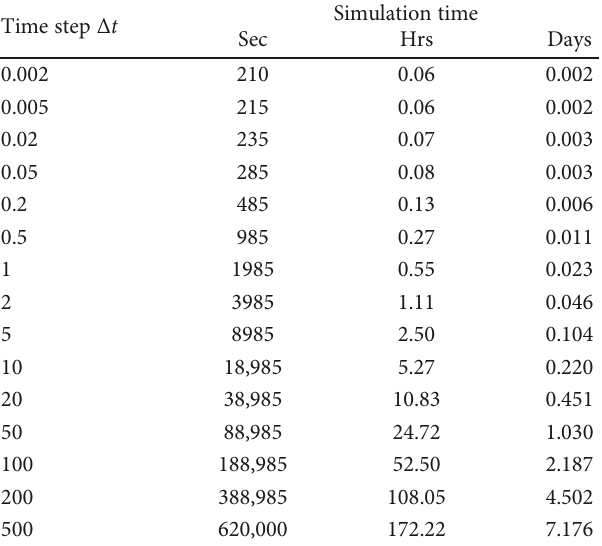
Table 4: Time steps used in consolidation analysis.